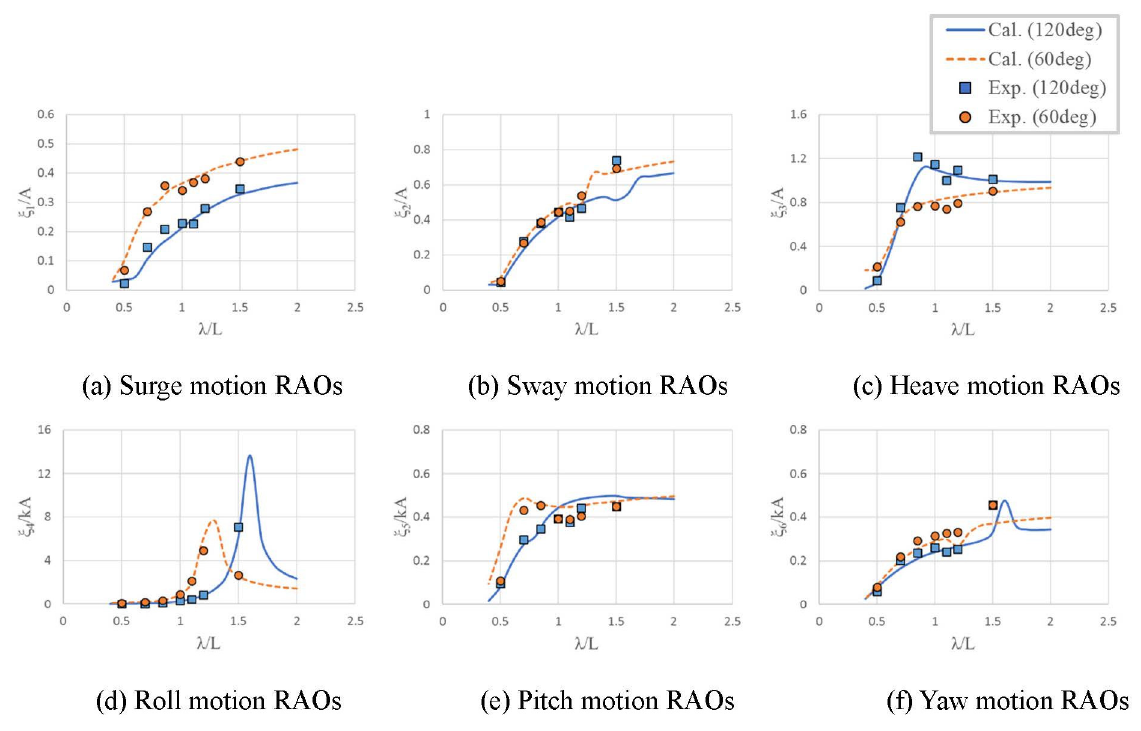
Figure 10. Motion RAOs of KVLCC2: V = 6 knots, H/L = 1/50.